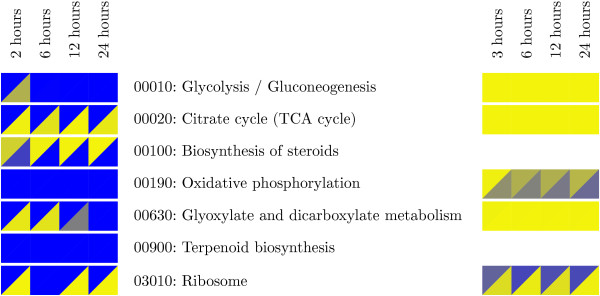
GSEA results for both transcriptomic and proteomic data. KEGG pathways identified as affected by hypoxia are shown. A heat map summarizes the differences and similarities observed between protein (4 columns on left) and transcript data (4 columns on right) for selected pathways. Upper-left triangles are for over-representation of increased transcript levels; lower-right triangles are for over-representation of decreased transcript levels. Yellow indicates significance for over representation, blue indicates that the transcripts are not statistically over-represented.